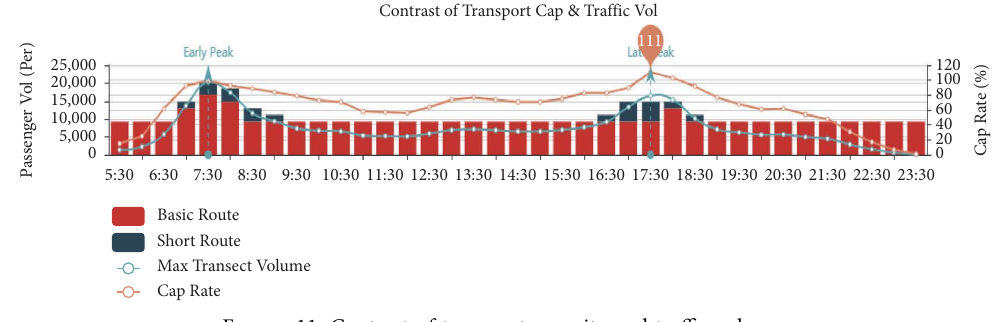
fow distribution in Figure 6.